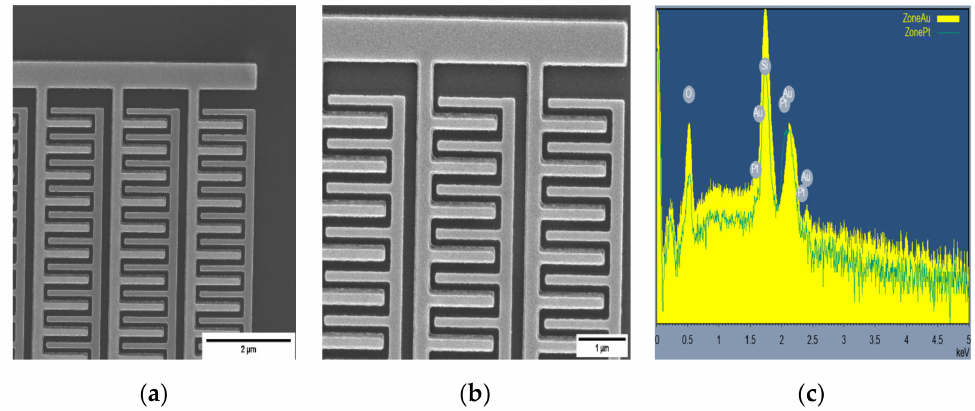
Figure 4. ( a , b ) SEM images of the device edge after oxygen plasma ashing and 13 min of resist stripping; and ( c ) EDX of Au/Pt and Pt zones.